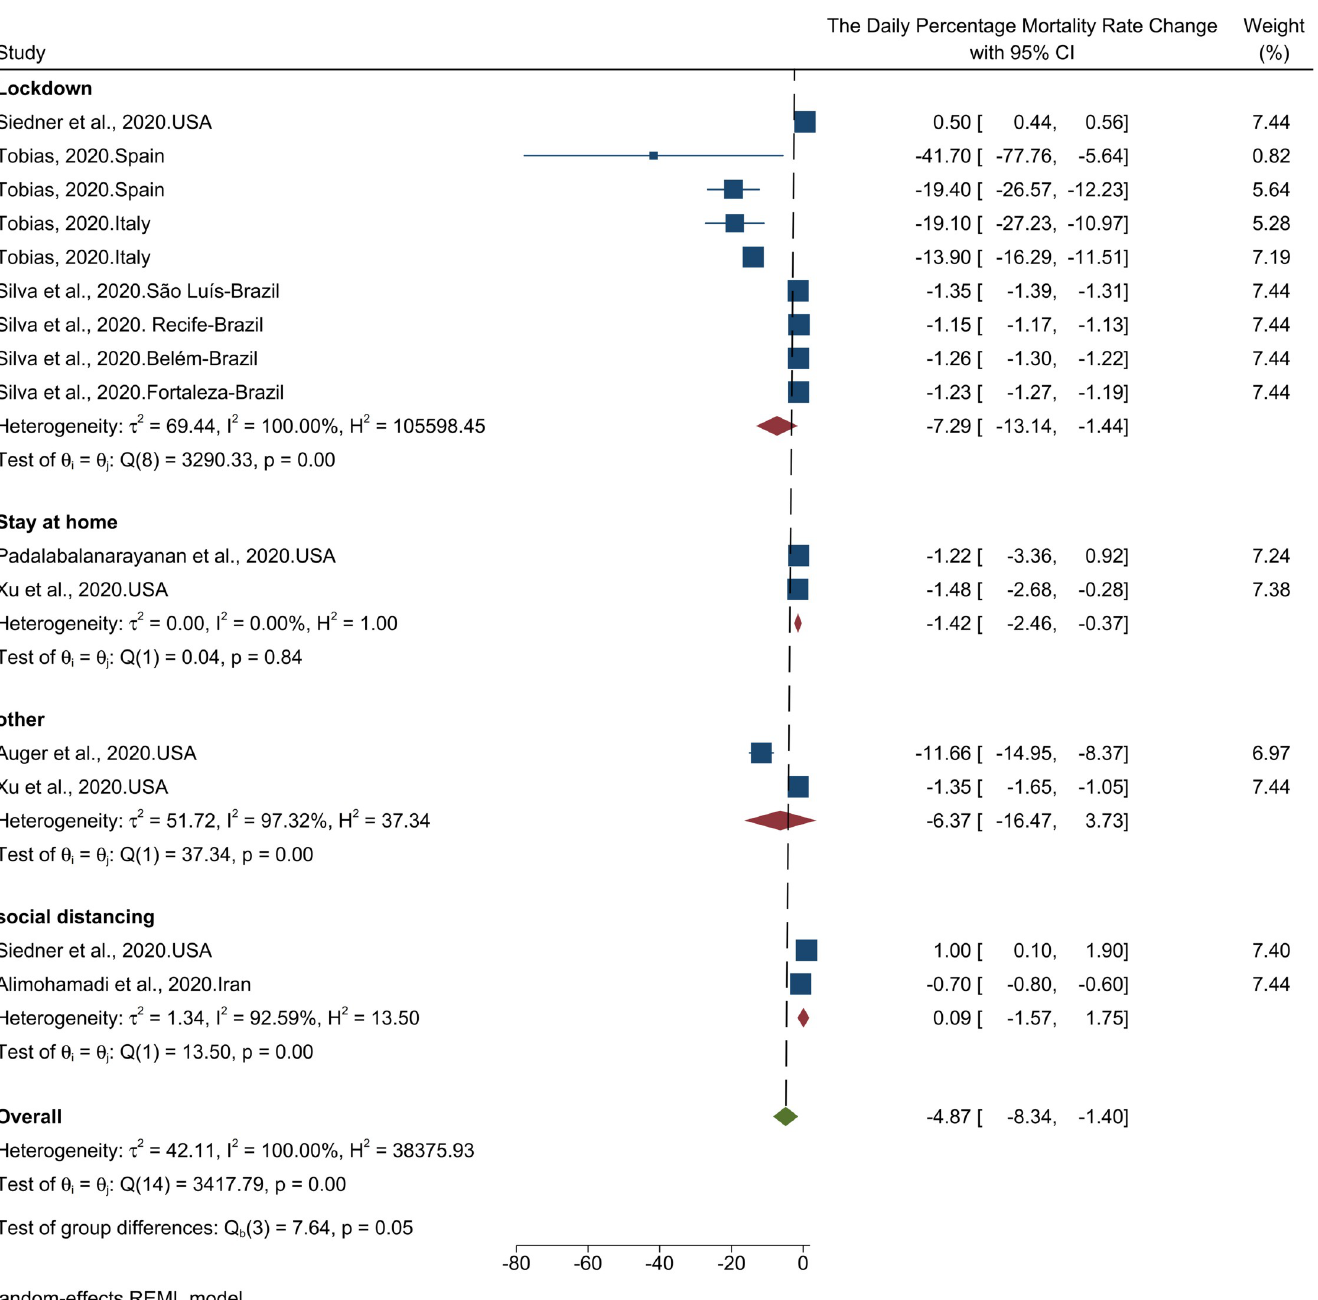
Fig 3. Results of the meta-analysis of the effect of NPHIs on the daily percentage changes of COVID-19 mortality growth rate in communities based on a random effect model.